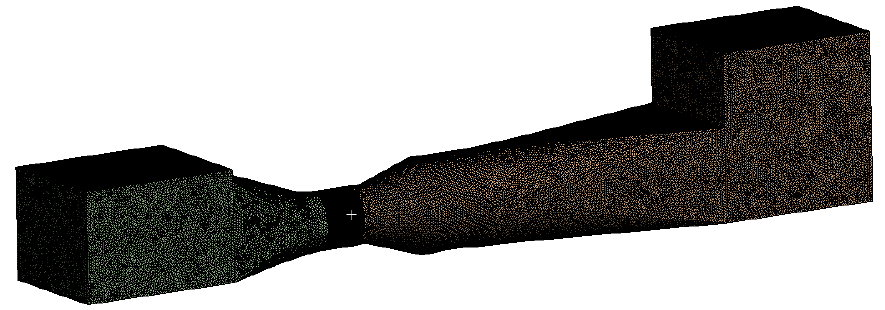
Figure 4. Grid of full channel calculation domain.